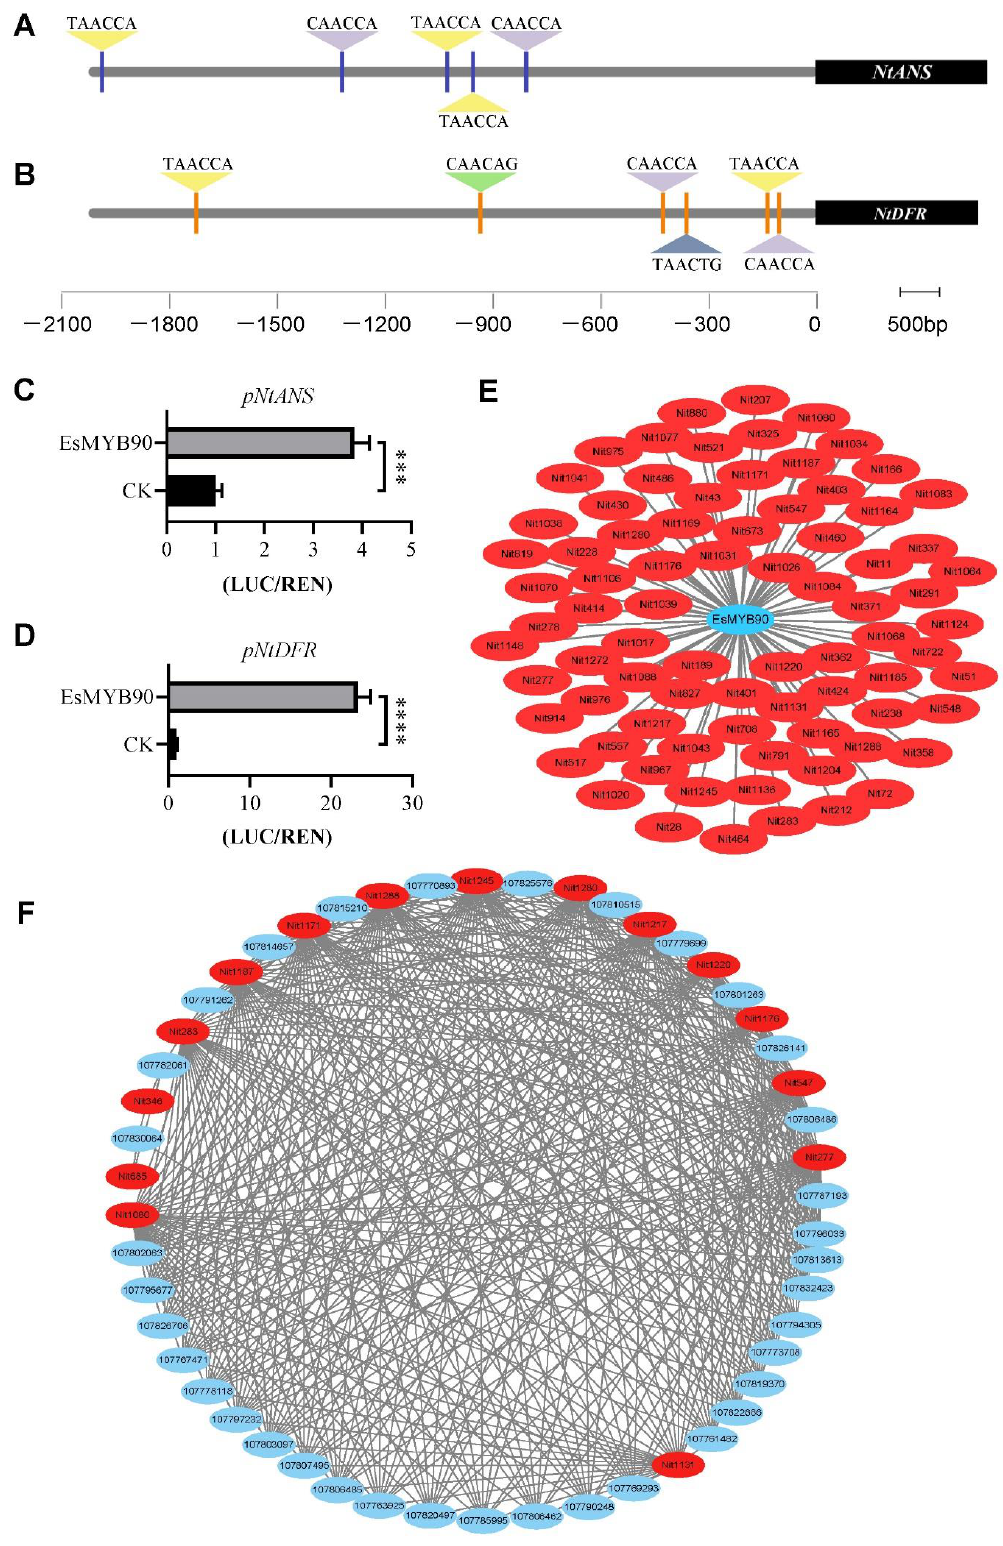
Figure 4. EsMYB90 activates transcription of flavonoid biosynthesis genes to modulate flavonoid metabolites in tobacco ( Nicotiana benthamiana ) leaves. ( A ) MYB-binding motifs analysis in NtANS promoter region. ( B ) MYB-binding motifs